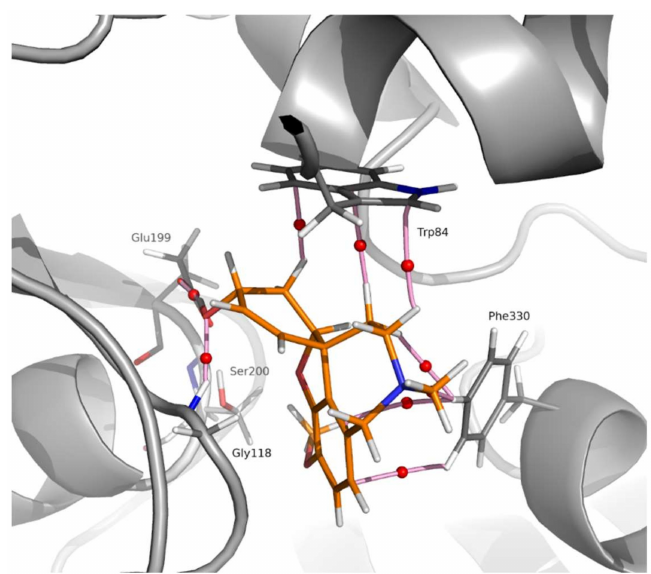
Figure 3. Molecular graph obtained for the non-covalent interactions between the main residues of AChE with galantamine (orange color). The structure of this complex was obtained from molecular dynamics simulations. The elements of the electron density topology are shown. The bond paths connecting the nuclei are represented in pink sticks and the bond critical points are shown as red spheres.